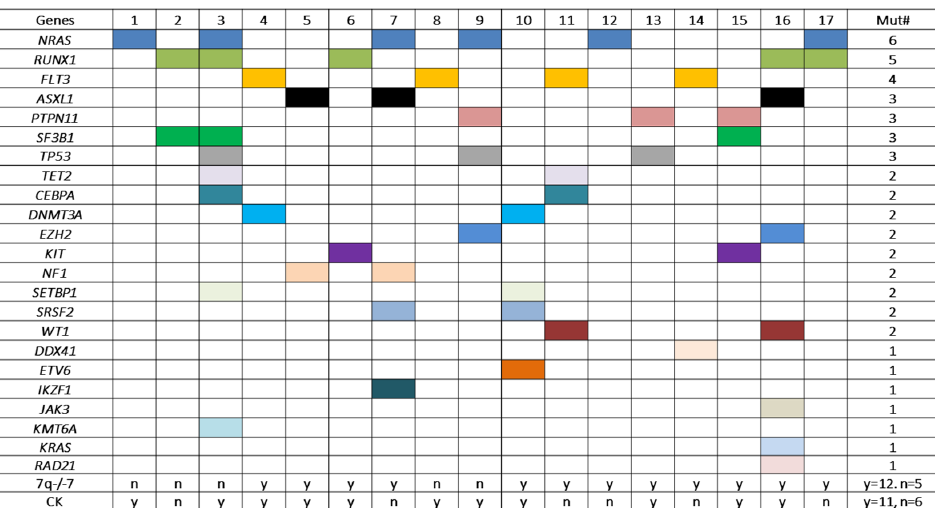
Figure 4. Gene mutations detected in patients with pericentric inv(3)s in this cohort. Each colored square represents a mutation event. All cases carried mutation(s) affecting at least one gene. Cases #16 and #3 had mutations involving seven and eight genes simultaneously. The first six genes ( NRAS, RUNX1, FLT3, ASXL1, PTPN11, SF3B1 and TP53 ) from the top showed frequencies of mutation of 3/17 to 6/17. However, no statistically significant association was found between the mutation frequencies and the status of − 7/7q- and/or complex karyotype. Mut: mutation; CK: